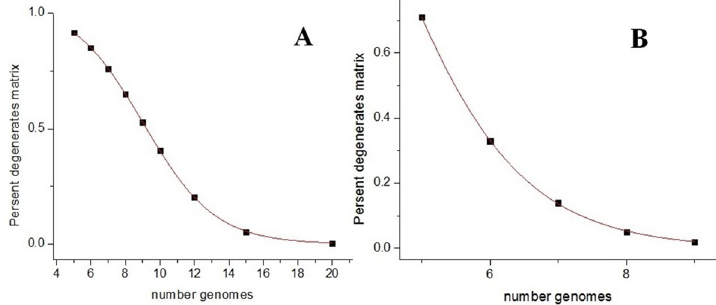
Fig 1. Probability of n samples randomly chosen from a metagenome composed of n different genomes being linearly dependent. (A) Each genome is present in the sample with equiprobable multiplicity of 0 or 1. (B) The same for four equiprobable multiplicities (0, 1, 2, and 3). x -axis: the number of different genomes in the metagenome; y -axis: percentage of linearly dependent